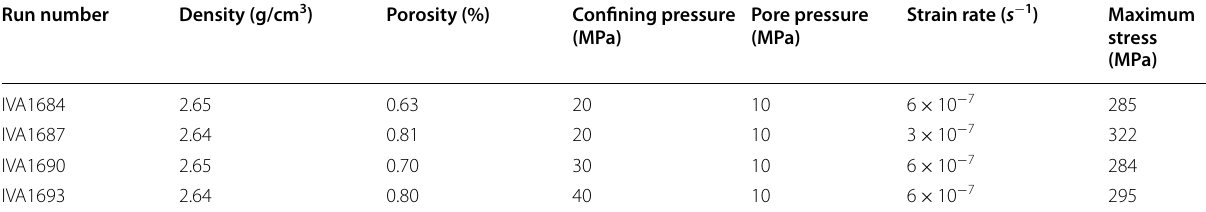
polarized in the horizontal plane (see Zaima and Katay- ama (2018) for further detail). The electrical resistivity